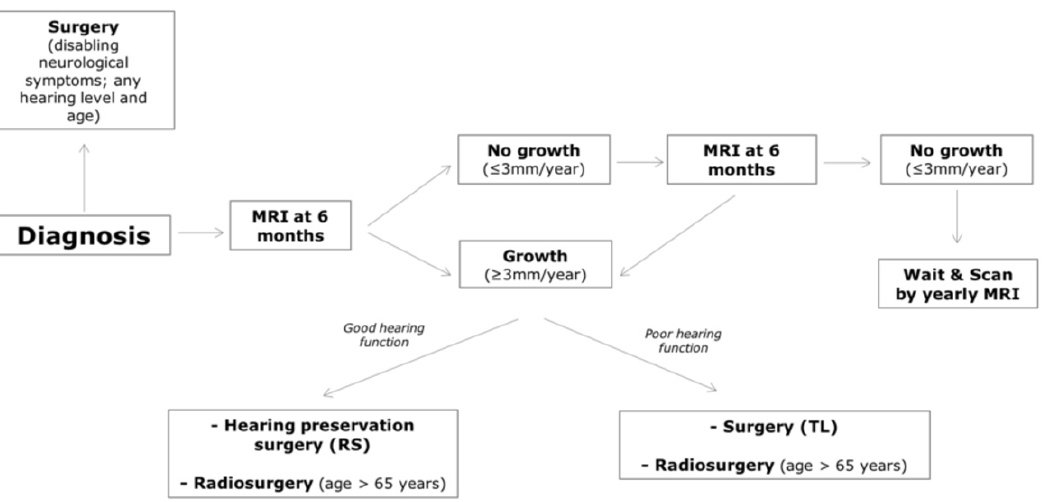
Figure 2. Algorithm proposed by Sergi et al. [3] to predict individualized decision-making in VS management.